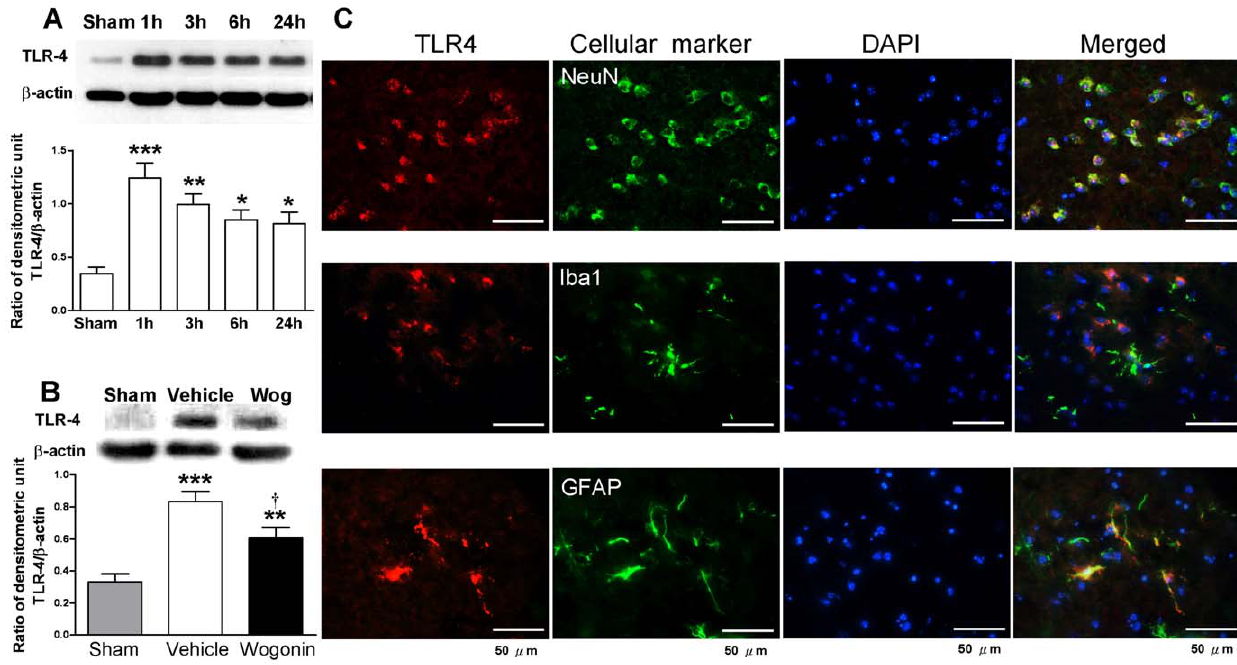
Figure 7. Effects of 40 mg ? kg 2 1 wogonin on TLR4 expresssion. ( A ) Representative immunoblots of toll-like receptor (TLR)-4 protein in the ipsilateral hemisphere from untreated injured mice. Bar graphs of densitometry analysis of the protein bands showed increased TLR4 levels at 1, 3, 6 and 24 h post-injury (n=5 mice/time point). ( B ) Representative immunoblots showing TLR-4 protein in the ipsilateral hemisphere from a sham- injured control, a wogonin-treated injured mouse, and a vehicle-treated injured mouse at day 1 post-TBI. Bar graphs of densitometry analysis of protein bands showed a significant decrease in TLR4 protein levels in the ipsilateral hemispheres of wogonin-treated mice at day 1 post-TBI compared with vehicle-treated mice. ( C ) Identification of TLR4- positive cells 1 day post-injury in the peri-contusion margin by immunofluorescence labeling. TLR-4 immunoreactivity is shown in red, and immunolabeling of NeuN (a cell marker for neurons), anti-ionized calcium binding adaptor molecule 1 (Iba1, a cell marker for microglia), or GFAP (a cell marker for astrocytes) is shown in green. Yellow labeling indicates co-localization. TLR4 was co-localized in neurons and astrocytes, and poor colocolization was observed in microglia. Sections were stained with DAPI (blue) to show all nuclei. The scale bar is 50 m m. Values are reported as means 6 SEM; * P , 0.05, ** P , 0.01, *** P , 0.001 versus sham controls, and { P , 0.05 for wogonin- treated versus vehicle-treated TBI mice (n=7 mice/group).